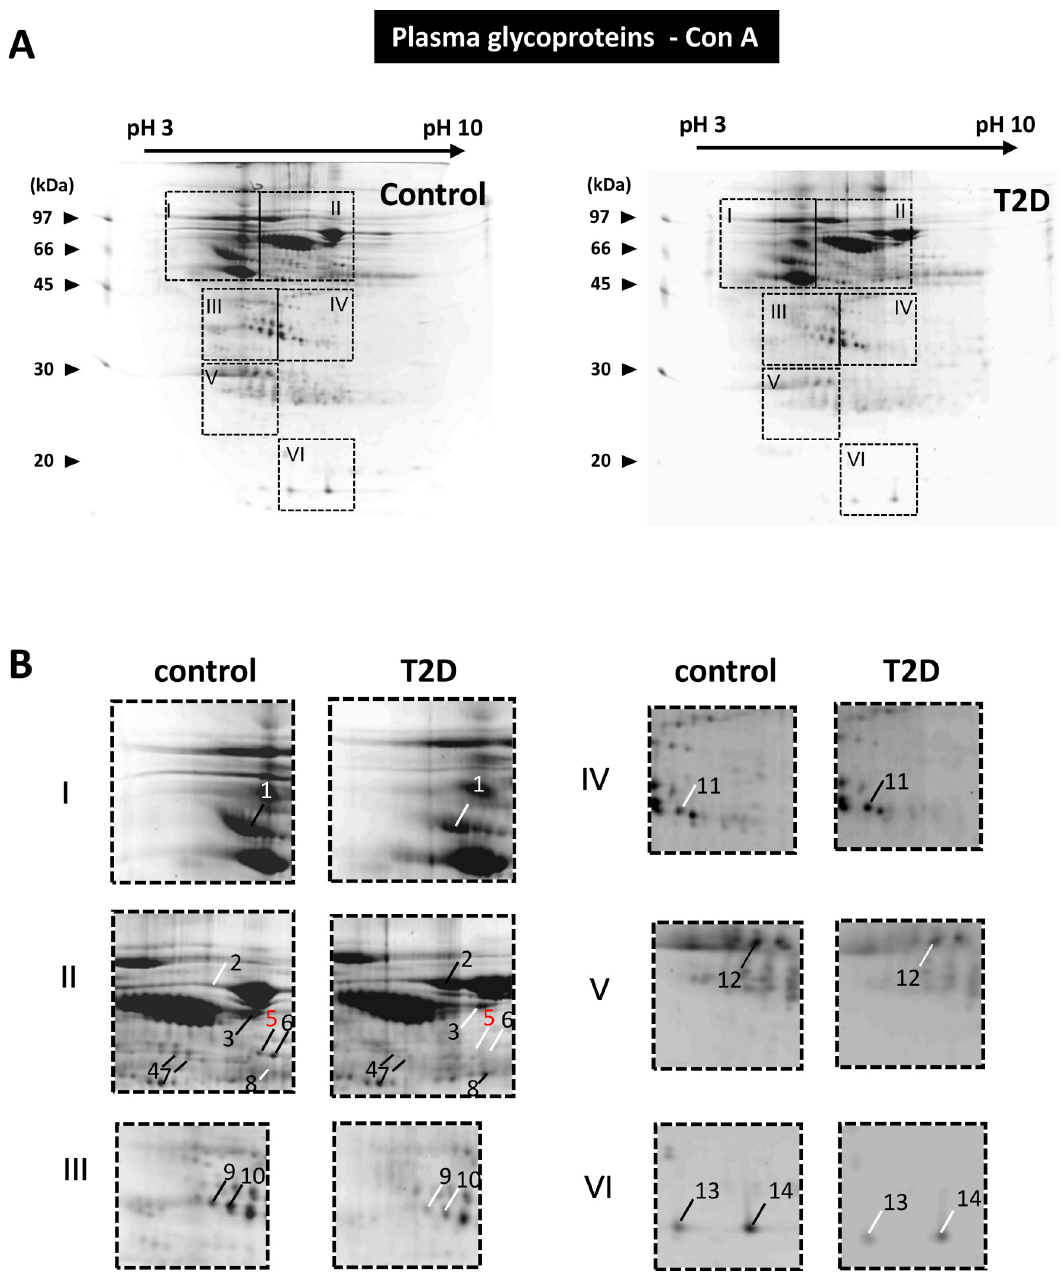
Fig 4. Differentially expressed glycoproteins in the control and T2D serum pools. (A) The results of the 2-DE analysis of ConA resin-enriched glycoproteins from the control and T2D serum pools. The dashed lines highlight six image sections of interest. (B) Two fold enlargement of the image sections indicated in Fig 4A . In comparison to the paired images, protein spots that exhibited relatively high or low expression are indicated by black and white lines,